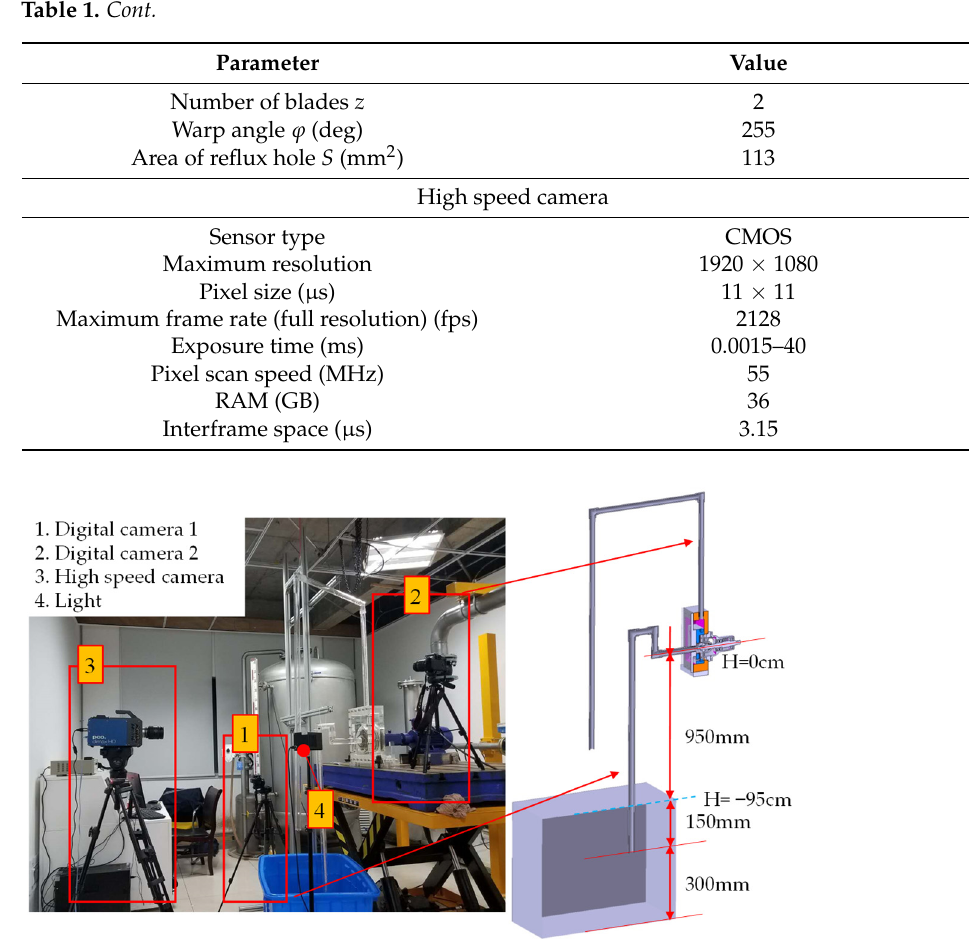
Figure 3. Visualization test bench. Table 1. Parameters of the test pump and high-speed camera.